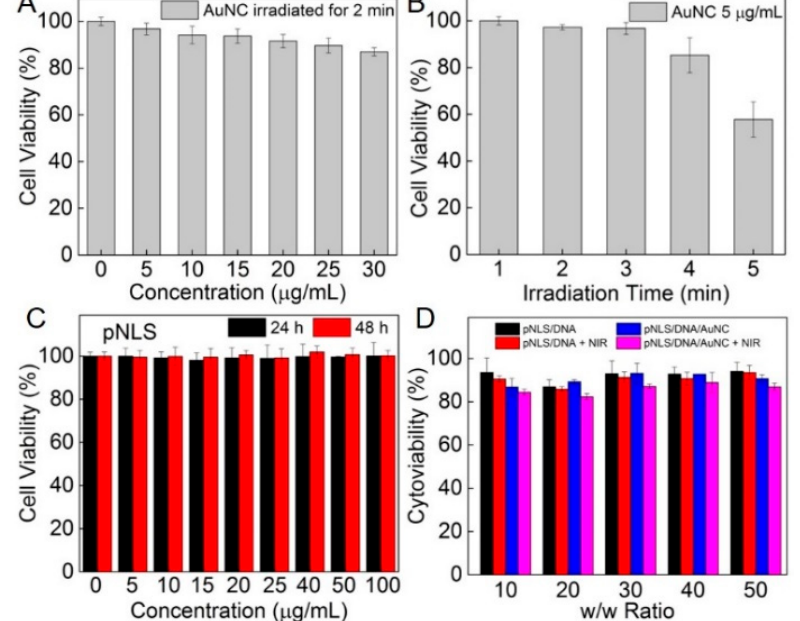
Figure 6. Cytotoxicity of AuNC under NIR irradiation ( A ) with different concentration and ( B ) for different exposure time; ( C ) cytotoxicity of cationic polypeptide pNLS; and ( D ) photo/dark toxicity of pNLS/DNA binary complexes and pNLS/DNA/AuNC complexes. Data are shown as mean ± S.D. ( n = 6).